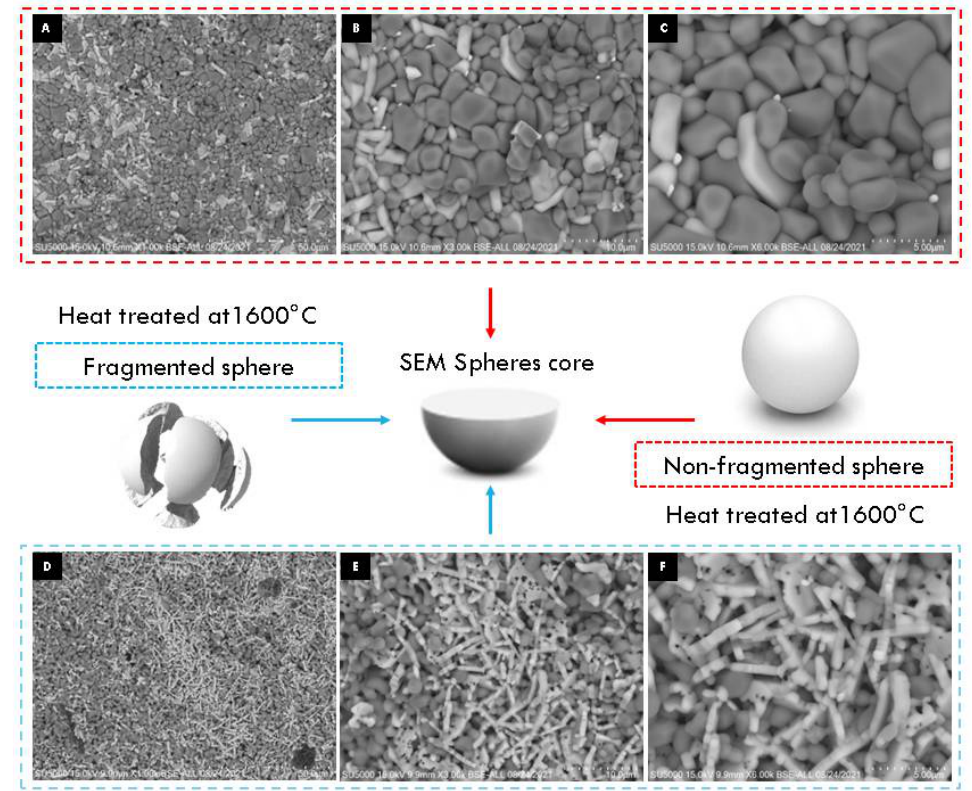
Figure 10. SEM micrographs of non-fragmented ( A – C ) and fragmented ( D – F ) alumina spheres treated at 1600 °C.